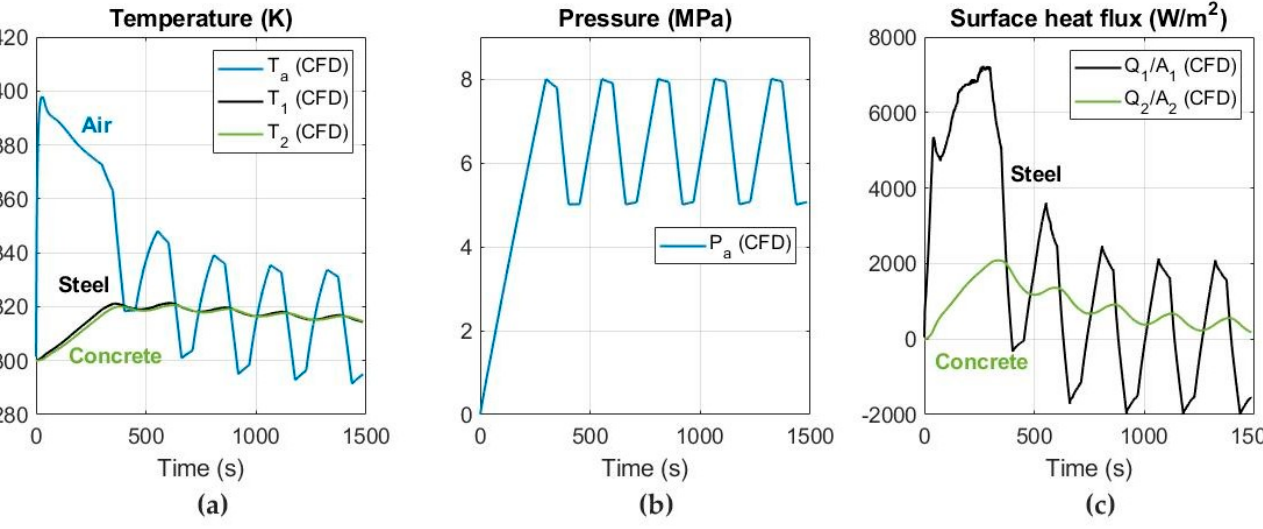
Figure 10. Numerical model results for 5 charging and discharging cycles considering steel as sealing layer. ( a ) Temperature of air, steel and concrete lining; ( b ) Air pressure; ( c ) Surface heat flux of steel and concrete lining.